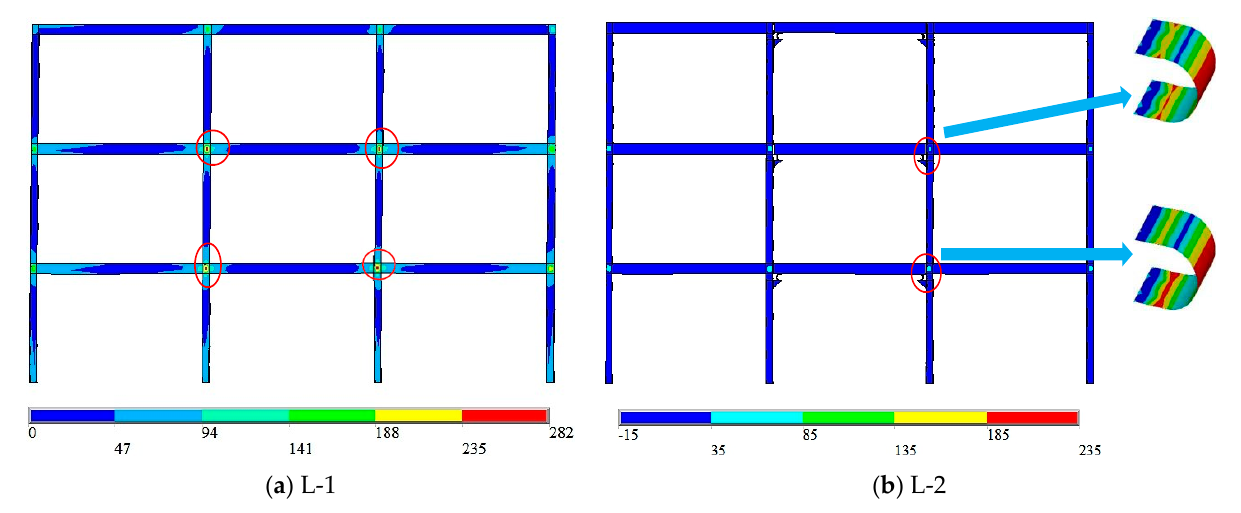
Figure 18. Stress nephogram of multi-story frame.